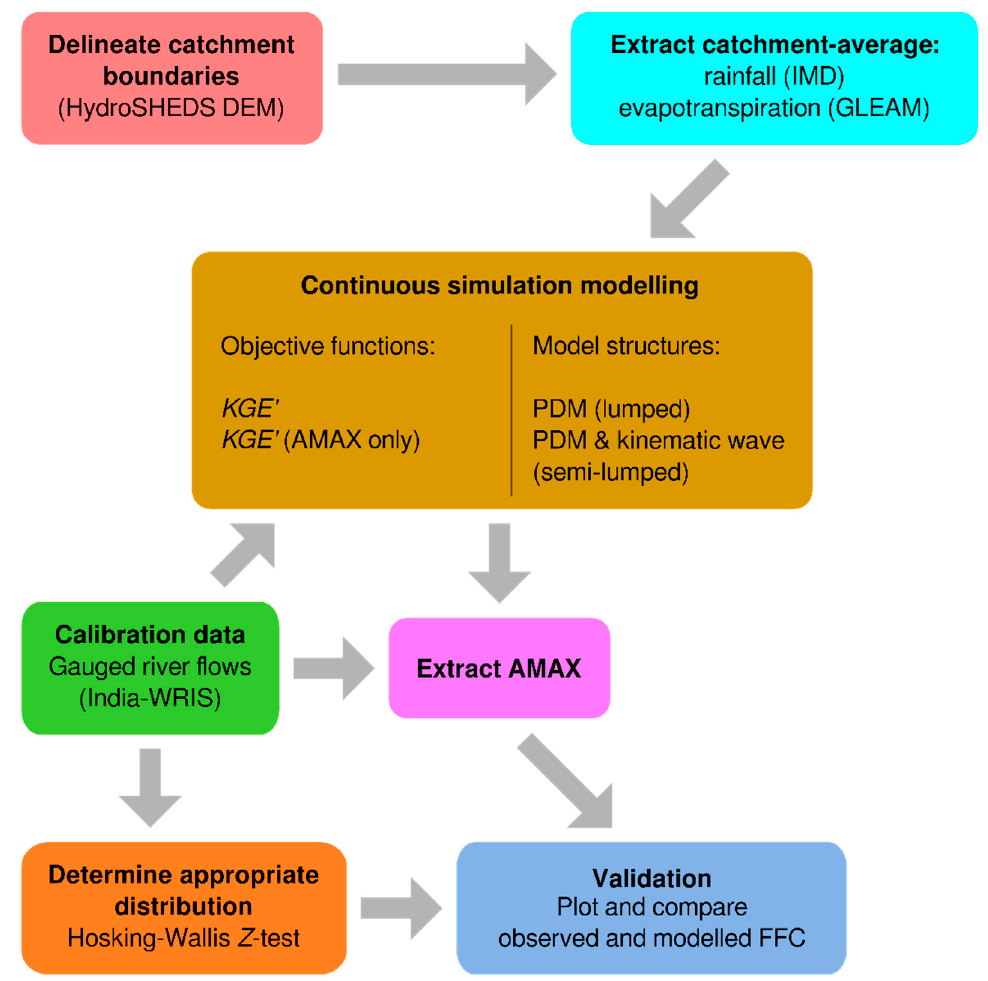
Figure 2. Study methodological diagram.